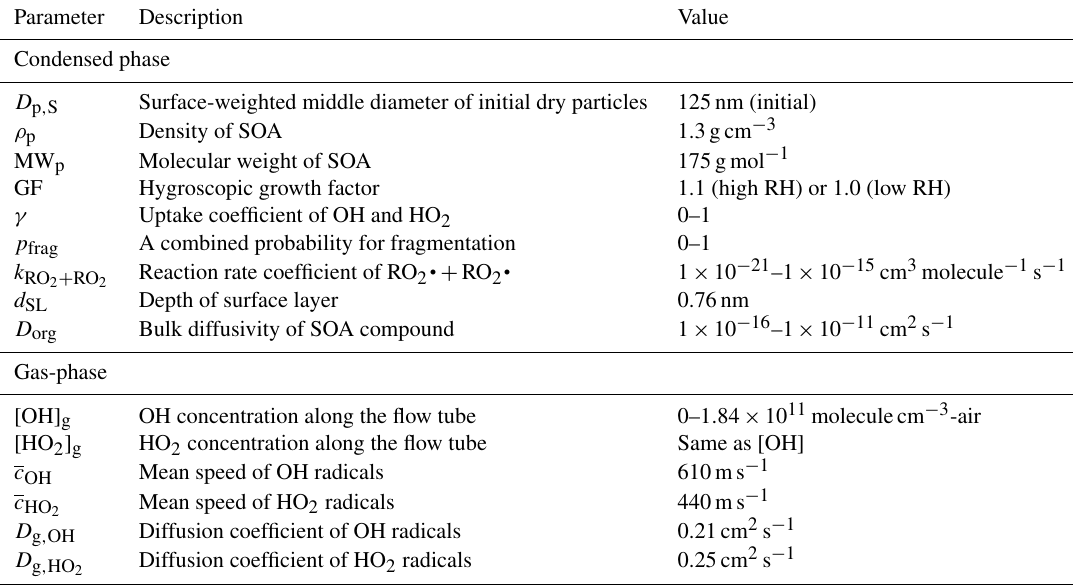
Table 2. Summary of values or ranges of values for parameters used in the model simulation.